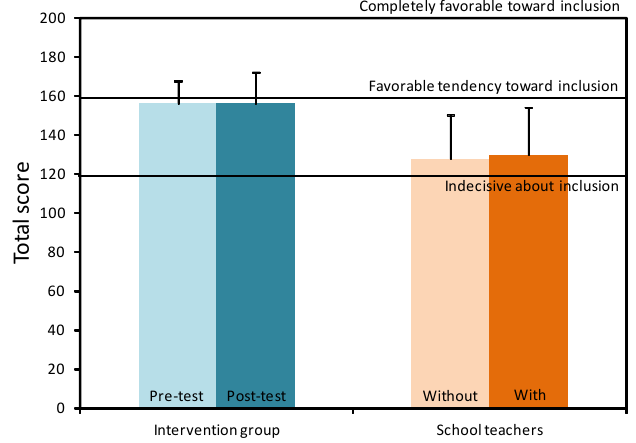
Figure 1. Total score in the attitude questionnaire for the IG group before and after intervention, and the CG without experience in inclusion (CGno) and with experience